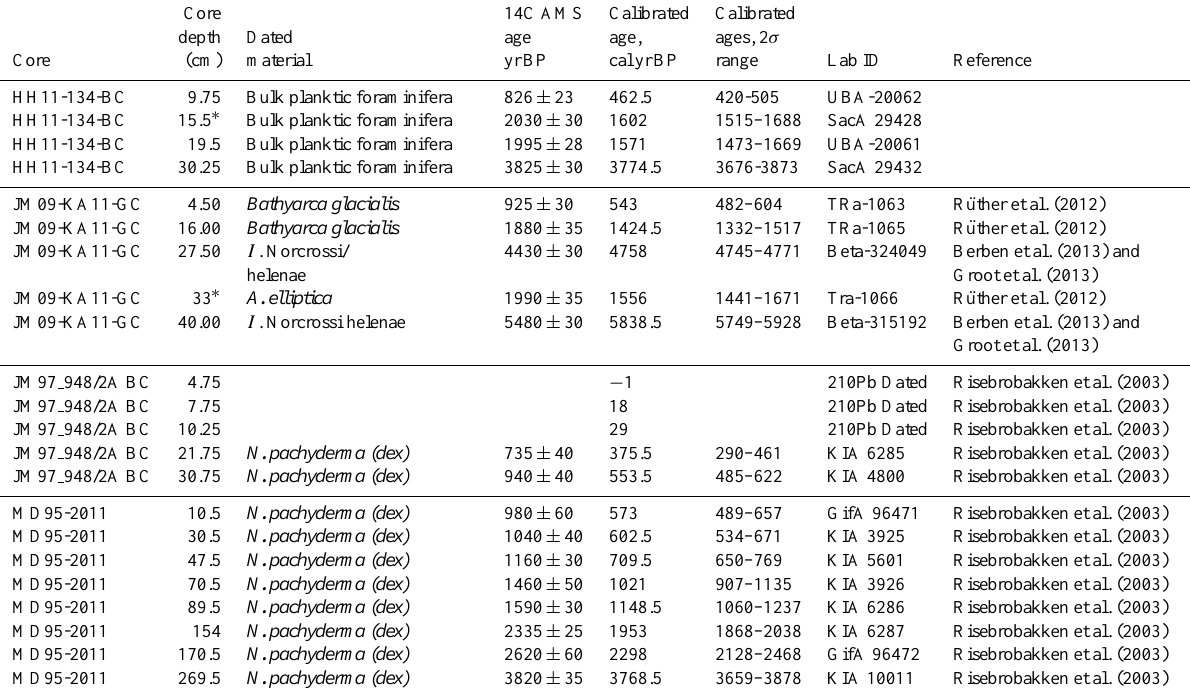
Table 2. Core, sample depth, dated material, 14 C AMS age years BP, calibrated years BP, Laboratory ID and